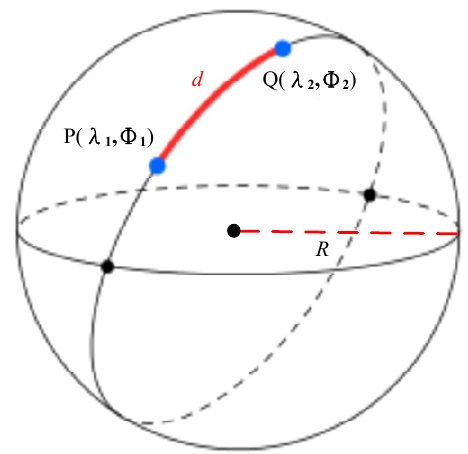
Figure 3. Three-axis orientation sensing of the attitude indicator of the STB.